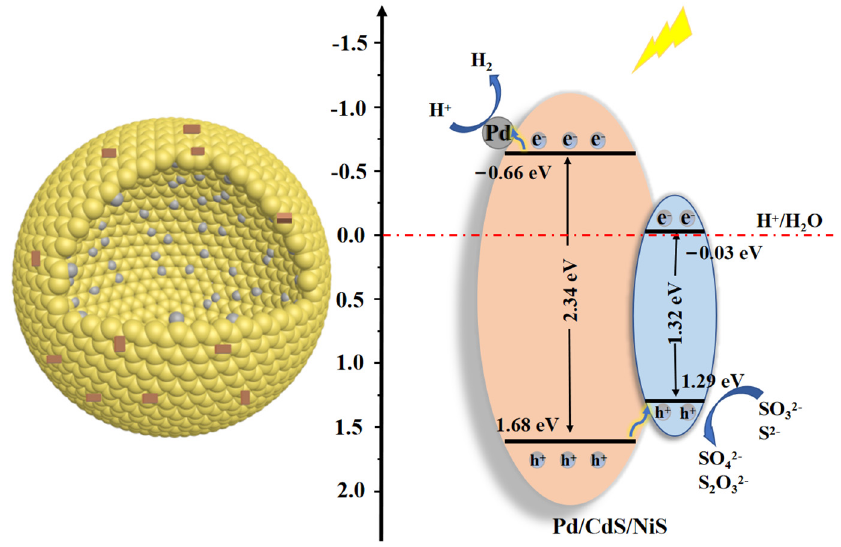
Figure 8. Schematic diagram of the photocatalytic reaction mechanism of the Pd/CdS/NiS.